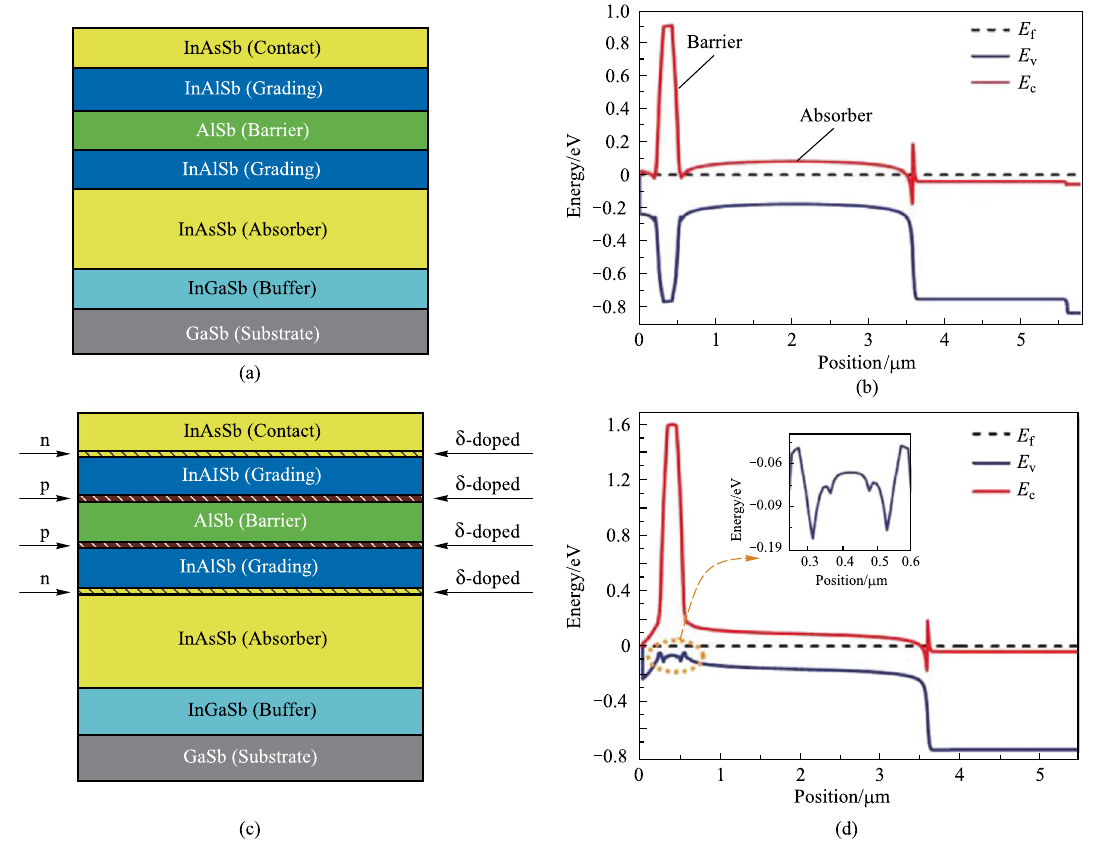
Fig. 2 InAsSb-Based nBn IR-Photodetectors; a Device structure and b energy band diagram with compositionally graded barrier (CGB) layer. c Device structure and d energy band diagram with δ-doped compositionally graded barrier (δ-DCGB) layer. The position in the vertical direc- tion is calculated by taking the upper surface of the device as the